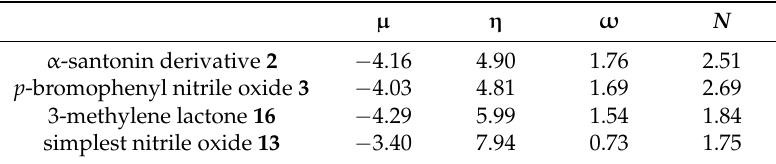
Table 1. B3LYP/6-31G(d) electronic chemical potential ( µ ), chemical hardness ( η ), electrophilicity ( ω ), and nucleophilicity ( N ), in eV, of α -santonin derivative 2 and p -bromophenyl nitrile oxide 3 , nitrile oxide 13 and 3-methylene lactone 16 .